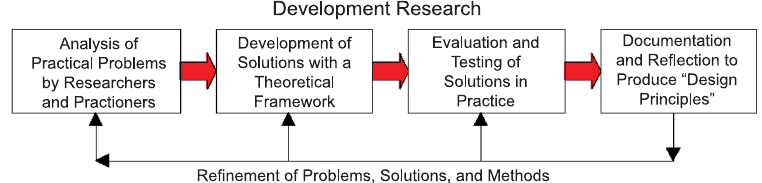
Figure 1. Development research process as outlined by Reeves (2000,